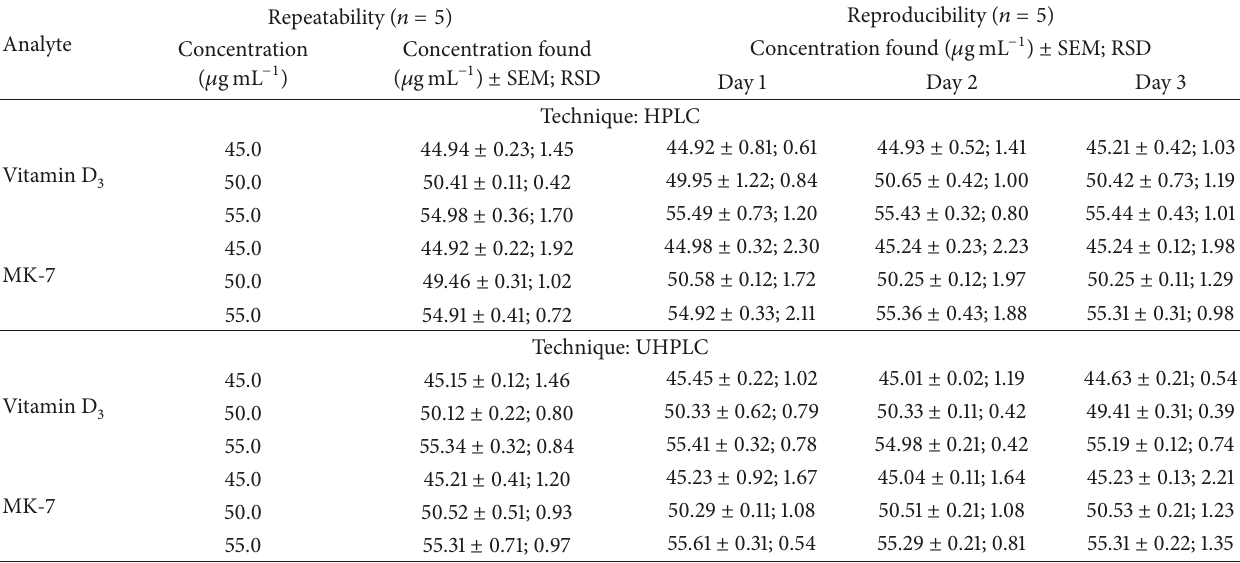
Table 5: Precision studies of vitamin D 3 and MK-7 by HPLC and